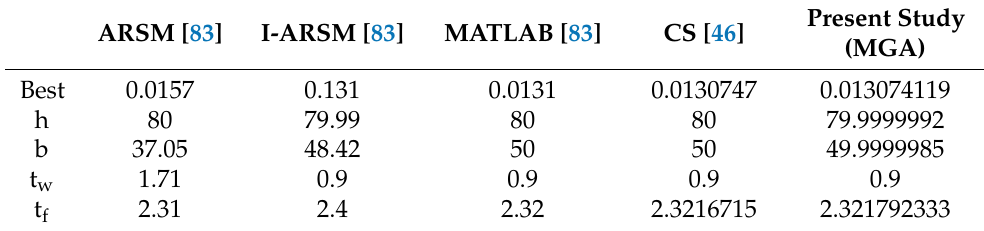
Table 24. Comparison of the best solutions for the steel I-shaped beam design problem.